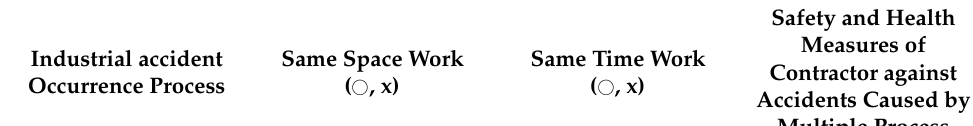
Table 10. Cases of crushed accidents by multiple processes in the